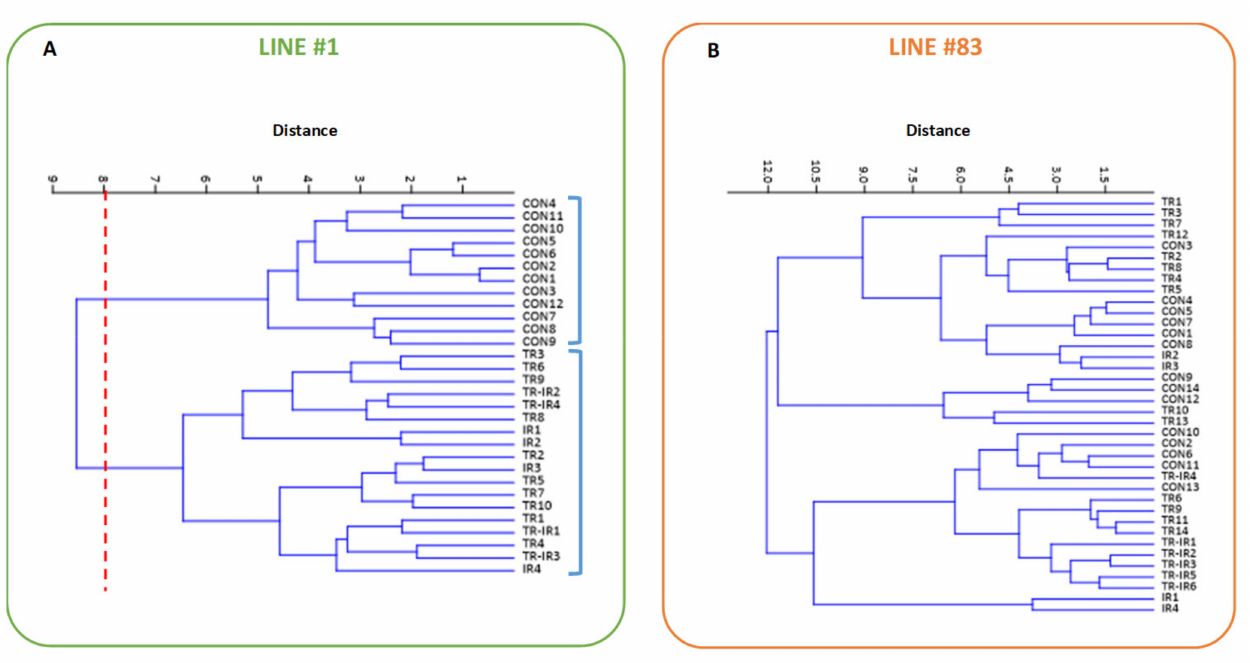
Figure 5. Clusters obtained from unsupervised hierarchical analysis for 10 metabolic parameters from 2D spectra (ML peaks A, B, and F; Myo-I, NAA, lactate, GSH-1; GSH-2; Gln and Glu, see Supplementary Figure S5B) of line #1 ( A ) and line #83 ( B ). CON—control samples; TR—ligand 190 treated samples; IR—irradiated samples; TR-IR—ligand 190 treated plus irradiated